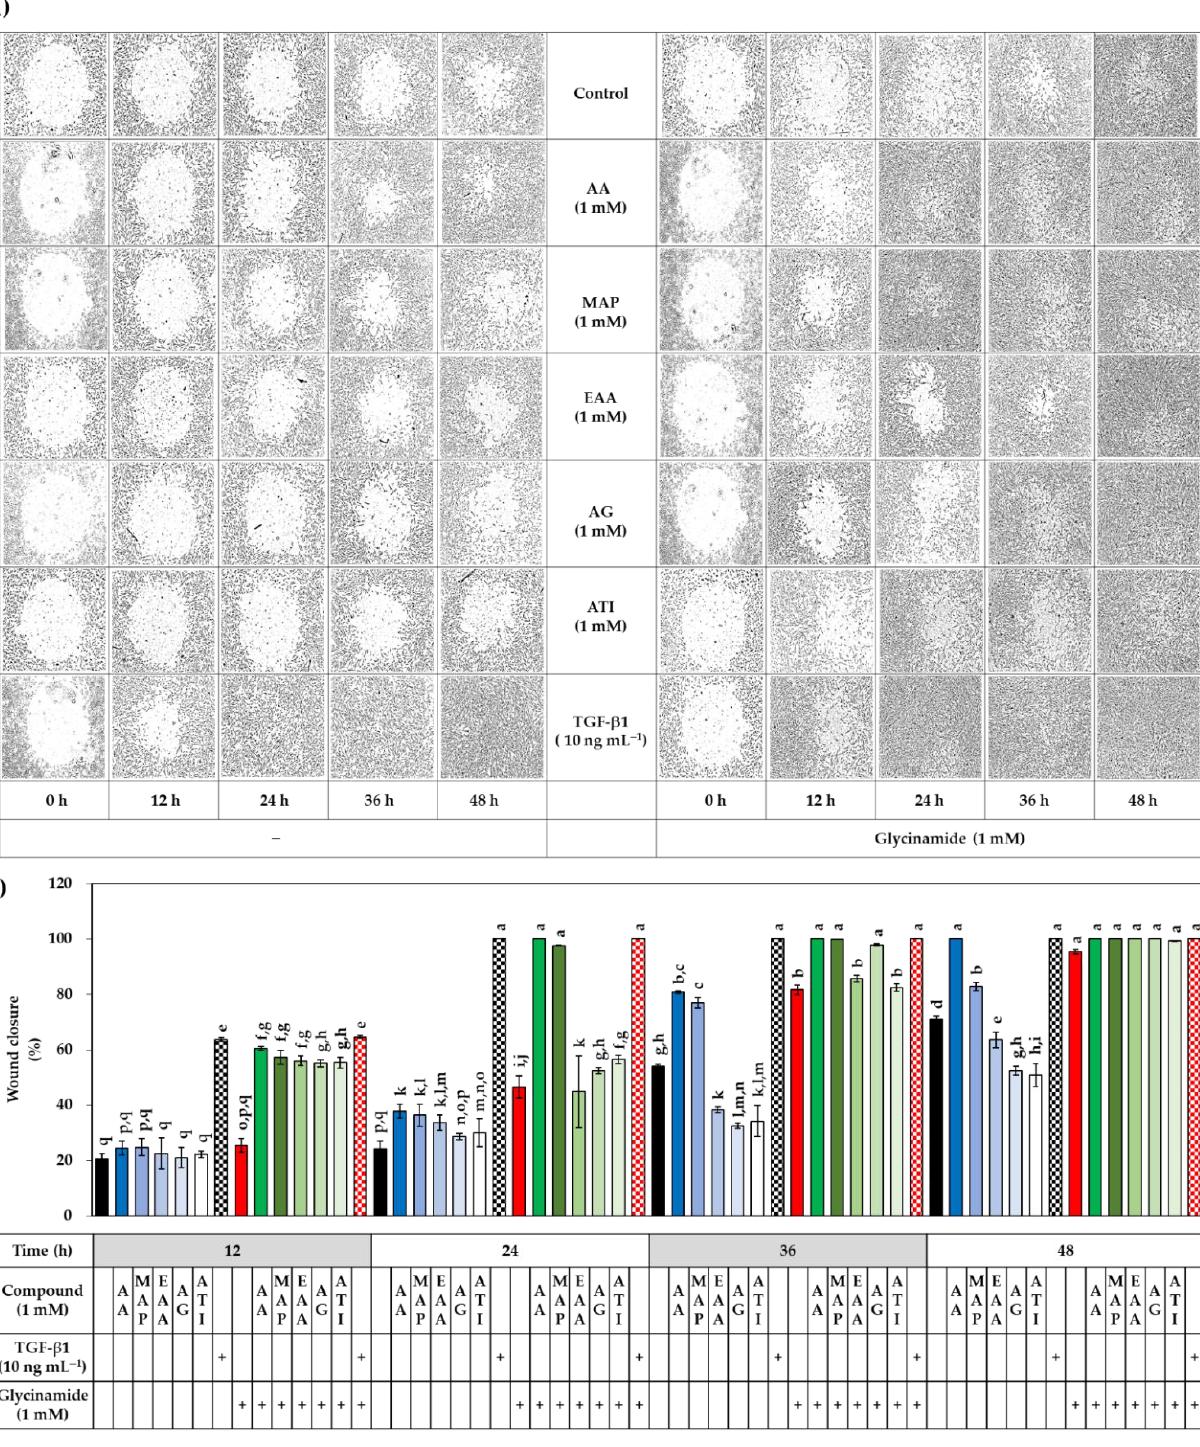
Figure 12. Effects of individual and combined treatments of AA analogs (such as AA, MAP, EAA, AG, and ATI), TGF- β1, and glycinamide on the wound closure in HDFs. Cells were cultured for 12 h in the presence of a stopper to create a small circular wound. After removing the stopper, cells were treated with an AA analog, or TGF- β1 for 48 h in the absence or presence of glycinamide. Representative microscopic wound images before and after treatments are shown in panel ( A ). Quantitated data for wound closure (%) are presented in panel ( B ) (means ± SD, n = 3). Groups that share the same alphabet letters (a – q) do not have significantly different means at the p < 0.05 level.